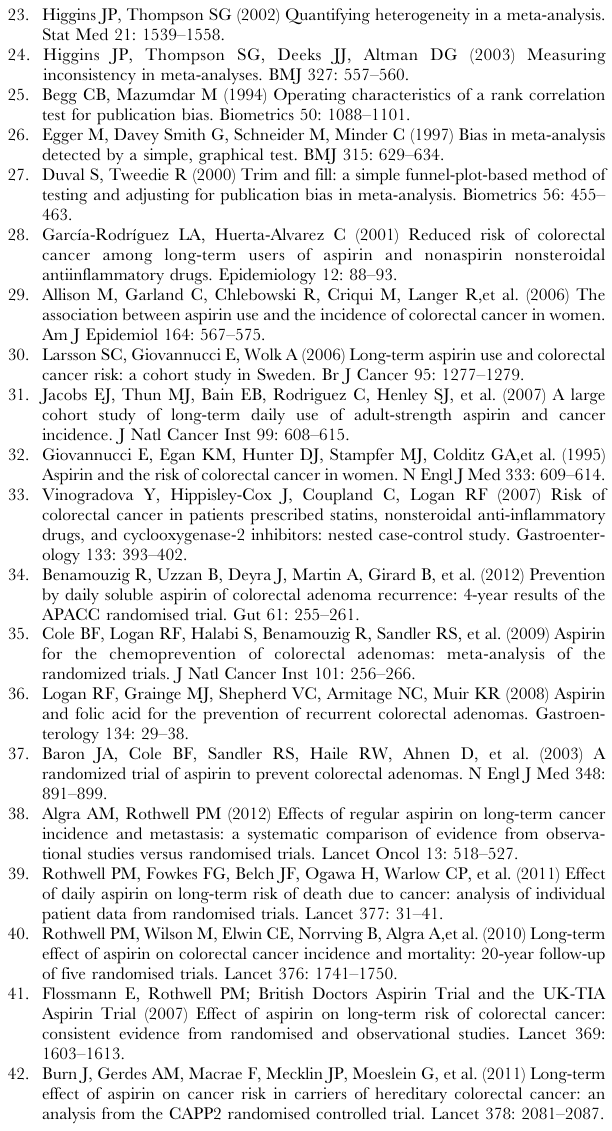
Figure S1 PRISMA Flow Diagram of literature search and study selection. Table S1 PRISMA checklist of this